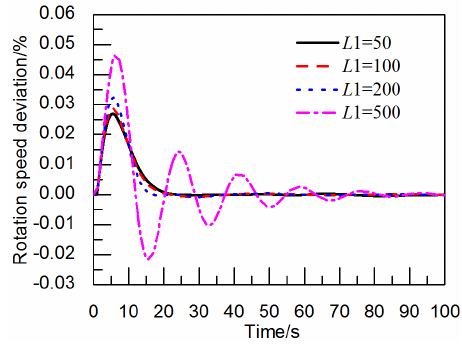
Figure 6. The influence of a pressure flow length (m) on the unit rotation speed.